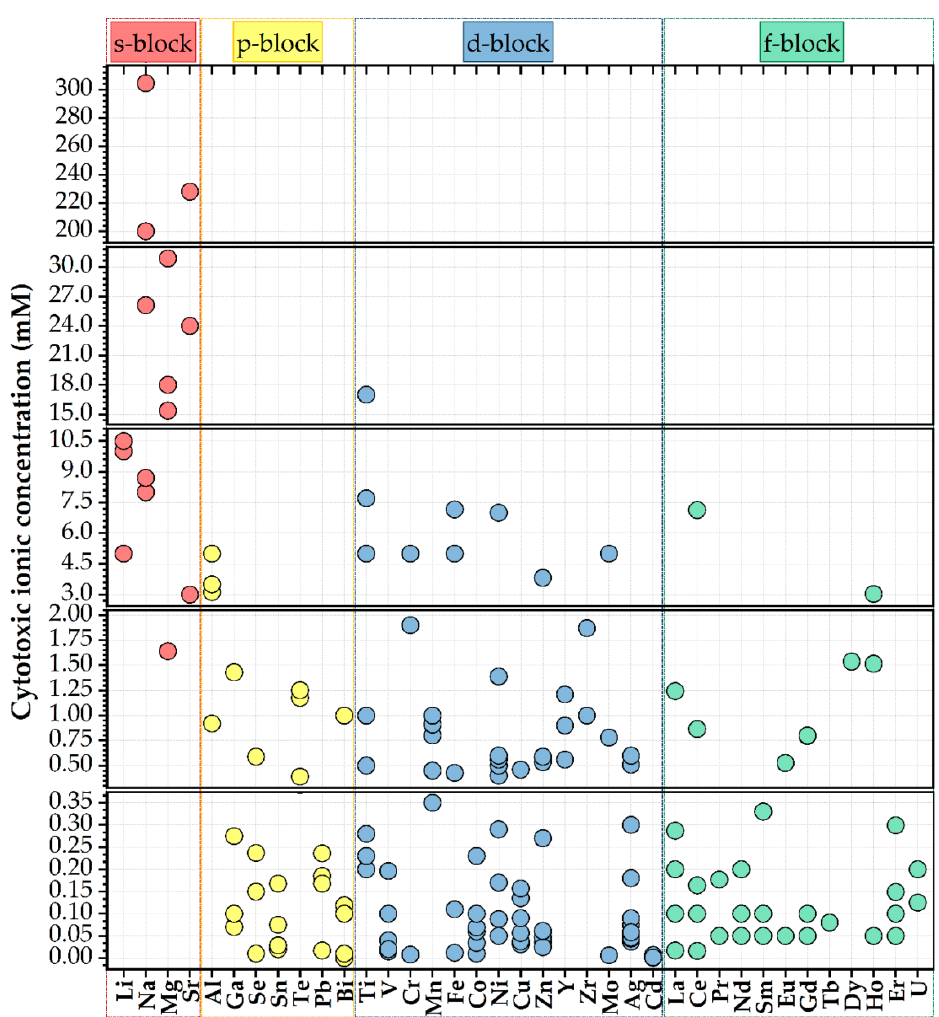
Figure 6. Half-maximal cytotoxic concentration (in mM) of various cationic species [36] .